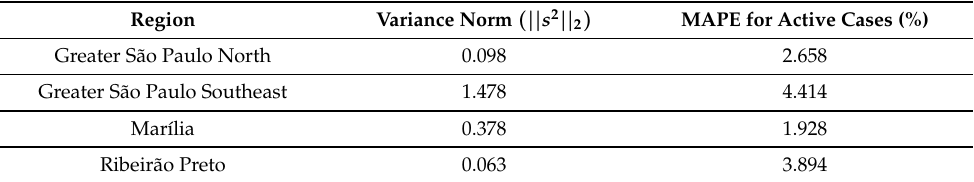
Table 2. Variance computed during the training process, and average MAPE for active cases (infected) with respect to Figure 6